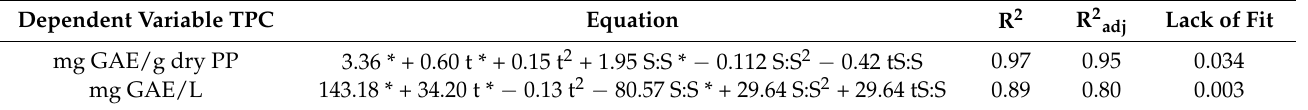
Table 2. Adjusted equation from RSM. Abbreviations: S:S—solvent:pineapple peel ratio; t—time. Dependent Variable